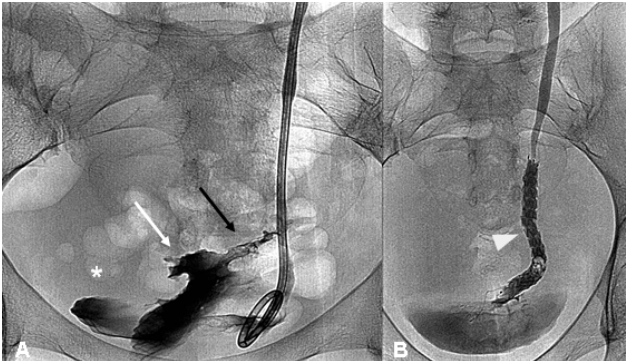
Figure 2. ( A , B )—A persistent fistula treated with ureteral stent. Left descending pyelographic study demonstrates a ureterovaginal fistula (black arrow) in the presence of a right DJ stent with opacification of both vaginal lumen (white arrow) and the bladder (asterisk) ( A ); removable metallic coated stent (white arrow head) is positioned without evidence of a fistula ( B ).